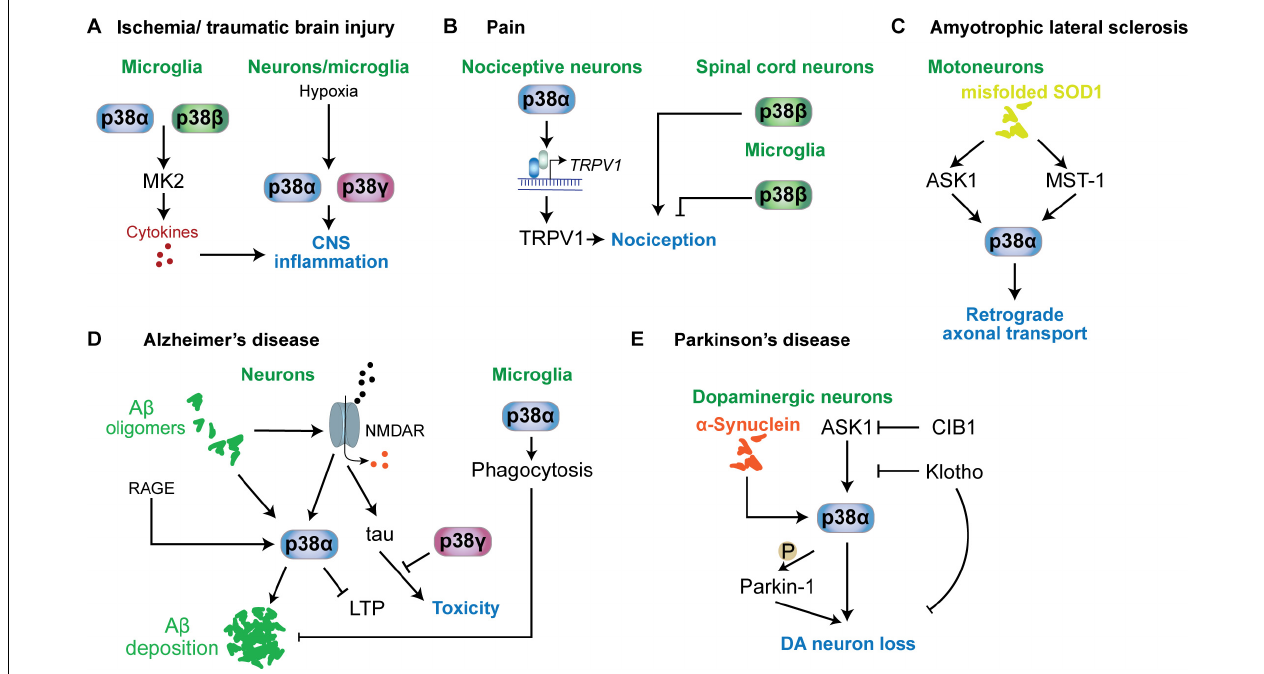
FIGURE 5 | p38 functions in neurological and psychiatric disorders. Mechanisms involving p38 kinases have been described for a variety of neurological and psychiatric disorders. (A) In ischemia or traumatic brain injury, microglial p38 α and p38 β contribute to neuroinflammation by targeting MAPKAP kinase-2 (MK2), which promotes the release of proinflammatory cytokines. This mechanism is relevant to other conditions associated with neuroinflammation. Hypoxia is a key stimulus activating p38 α and p38 γ in neurons and microglia. (B) In nociception and pain, p38 α in nociceptive neurons promotes the expression of TRPV1 channels that contribute to nociception. p38 β in spinal cord neurons promotes nociception, while microglial p38 β has an inhibitory role in nociception. (C) In ALS mouse models based on mutant SOD1, p38 α downstream of ASK1 or MST1 is activated and impairs retrograde transport. (D) In Alzheimer’s disease, neuronal p38 α can be activated by a variety of stimuli, including amyloid-beta, RAGE or aberrant glutamate receptor engagement. p38 α activity promotes amyloid aggregation, LTP and neuroinflammation. p38 γ inhibits the toxic function of tau in neurons by direct phosphorylation of tau. Interestingly, microglial p38 α reduces amyloid plaque load in models of AD by promoting phagocytic activity. (E) In Parkinson’s disease, p38 α in dopaminergic neurons is activated by alpha-synuclein aggregates. p38 α promotes DA neuron loss by direct phosphorylation of Parkin-1. Activity in DA neurons is regulated by ASK1 upstream of p38 α . This pathway can be inhibited by survival factors CIB1 and